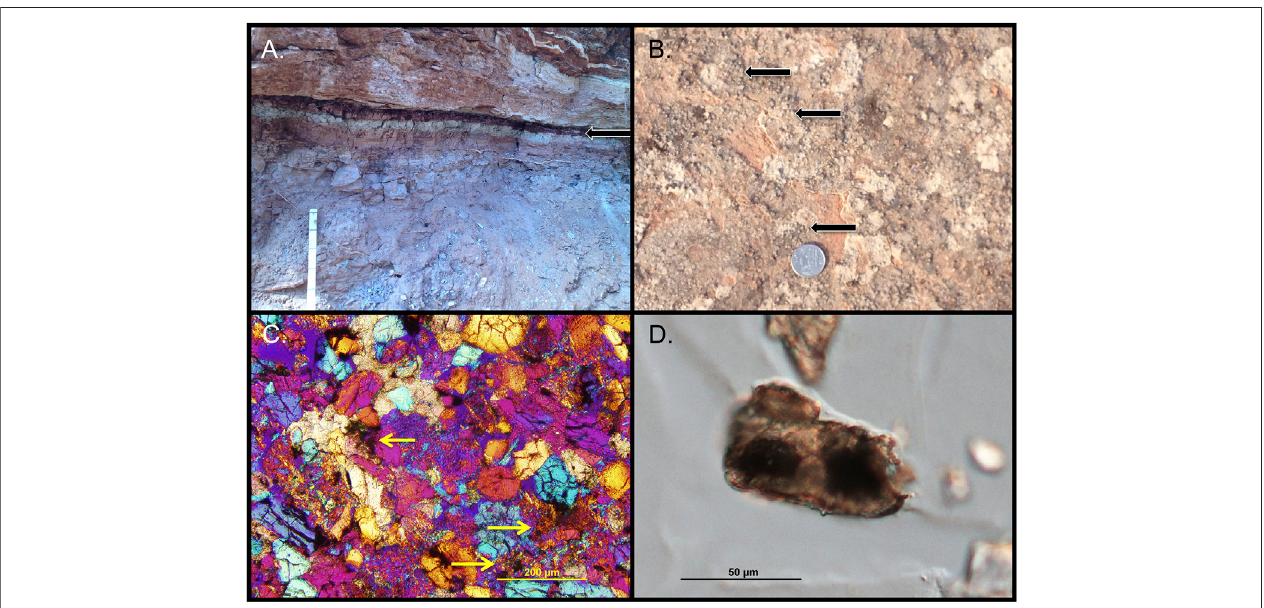
FIGURE5 |(A) Claystonefacies (indicated by arrow) exposed in the salt-lake facies (Whitehorse Group) ofCaprock Canyons stratigraphic section. Thisclaystone, the weathering product of a volcanic ash, occurs 17.8 m beneath the top of the Whitehorse strata in this stratigraphic section. See text for discussion. Jacob ’ s staff in foreground has 10 cm graduations. (B) Bladed calcite textures arranged into calcareous spherules and clusters of spherules that occlude coarse silt to fi ne-sand sized grains inthe sand- fl at facies beltof thestratigraphic section exposed near Dickens, TX U.S.A. See text for further discussion. (C) Transmitted-light, crossed nicols, photomicrograph of a very fi ne sandstone from the sand- fl at facies of the stratigraphic section exposed near Dickens, TX U.S.A. The blue, yellow and pink grains are detrital quartz sands, whereas the dark clotted areas are (some areas indicated by arrows) are zones of dolomicrite cementation. See text for discussion. (D) Re fl ected lightimage ofanopalinephytolith separatedfrombulk sedimentsampledfrom thesand- fl at faciesbeltintheCaprock Canyonsstratigraphicsection. Thedarkcoresare inclusions of plant organic matter. UCMP collection locality number PA1201h, specimen number 254961, England Finder Coordinate E25-1. See text for